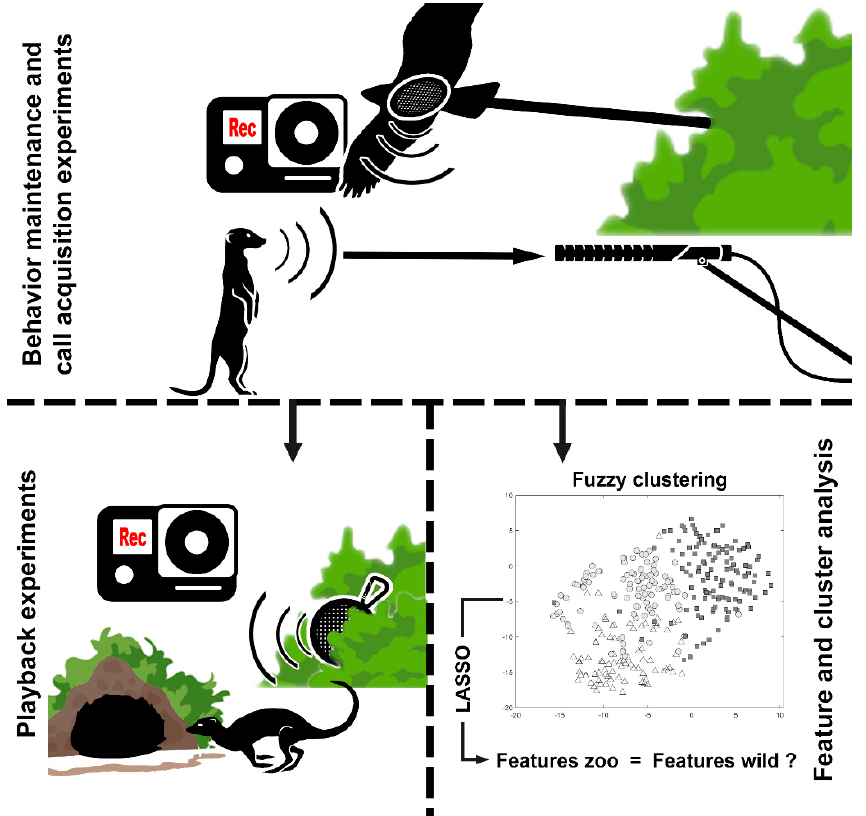
Figure 1. Visual representation of the three parts of this study. In the first step (experiments on behavior maintenance and call acquisition), we test whether meerkats exhibit natural behavior to detect and avoid enemies. For the following steps, alarm calls triggered by predator stimuli are recorded. The playback experiment is designed to determine whether captive meerkats still learn to respond appropriately to their own alarm calls. This is conducted by playing back the previously recorded aerial alarm calls and observing the response of the meerkats. The third approach is to investigate whether the graded structure of alarm calls is maintained in captivity. For this purpose, the acoustic features of the previously recorded aerial and terrestrial alarm calls are extracted and clustered. The LASSO algorithm is used to select the features that best describe the differences of the resulting clusters. If these features correspond to the features already described for wild meerkats, it can be assumed that the graded structure is preserved.